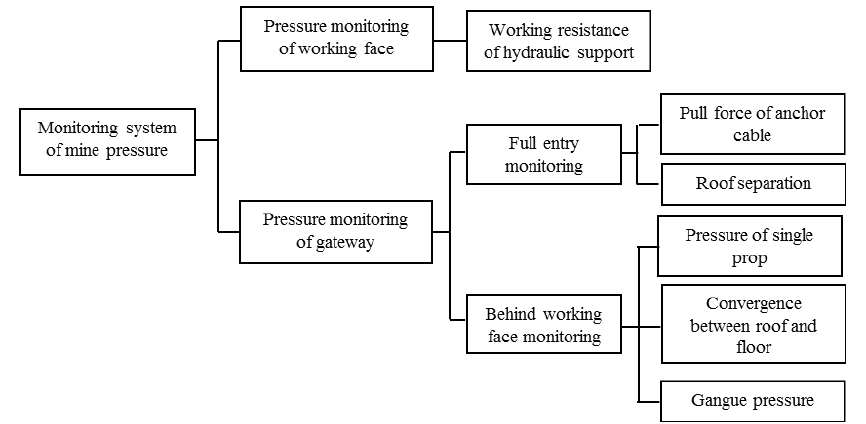
Figure 7 . Mine pressure monitoring system for GERRC .